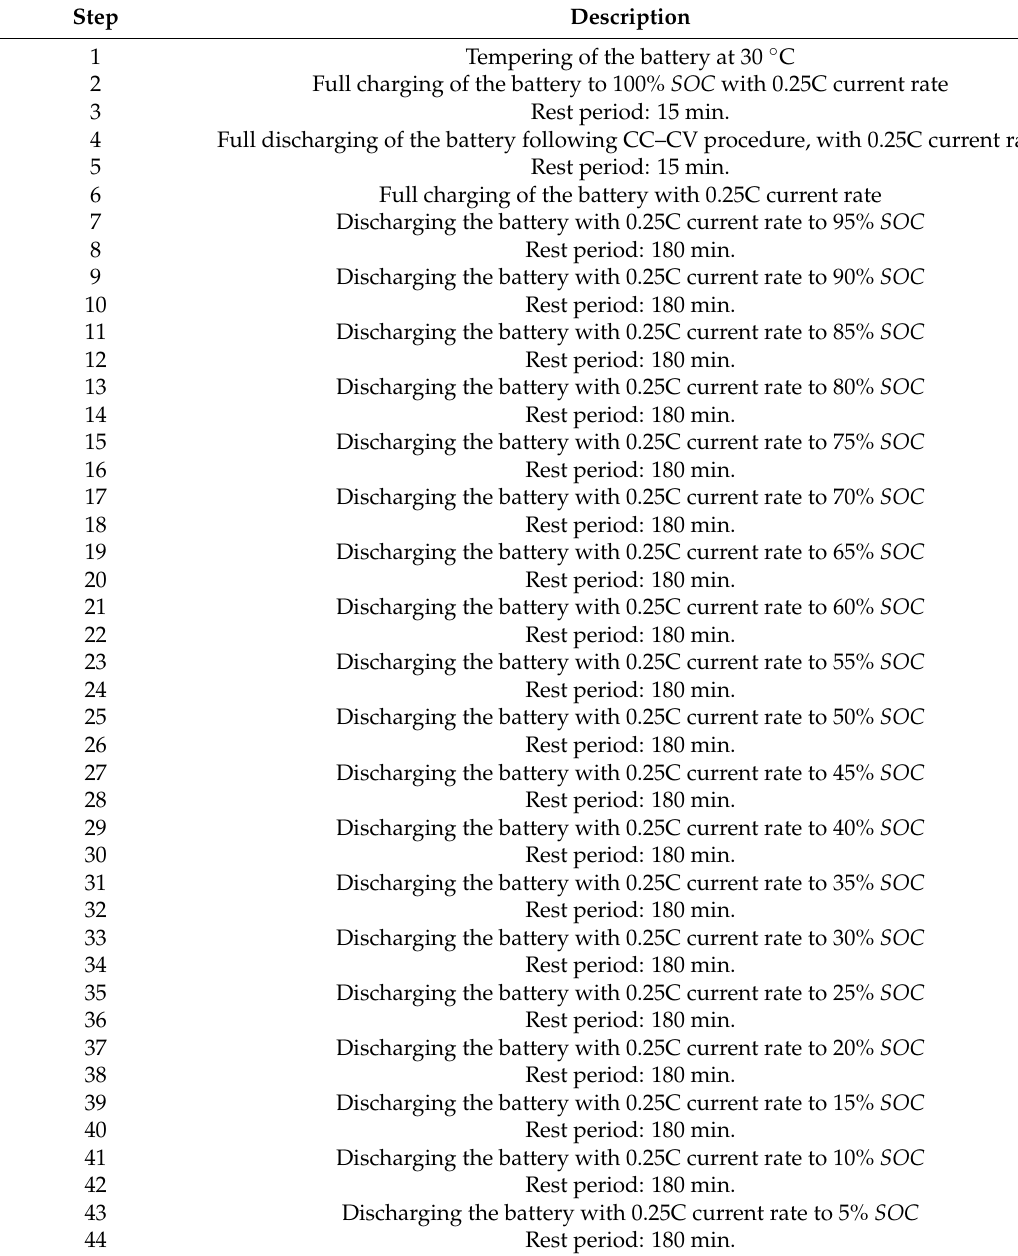
Table 1. Open circuit voltage test method for the battery cell. SOC : state of